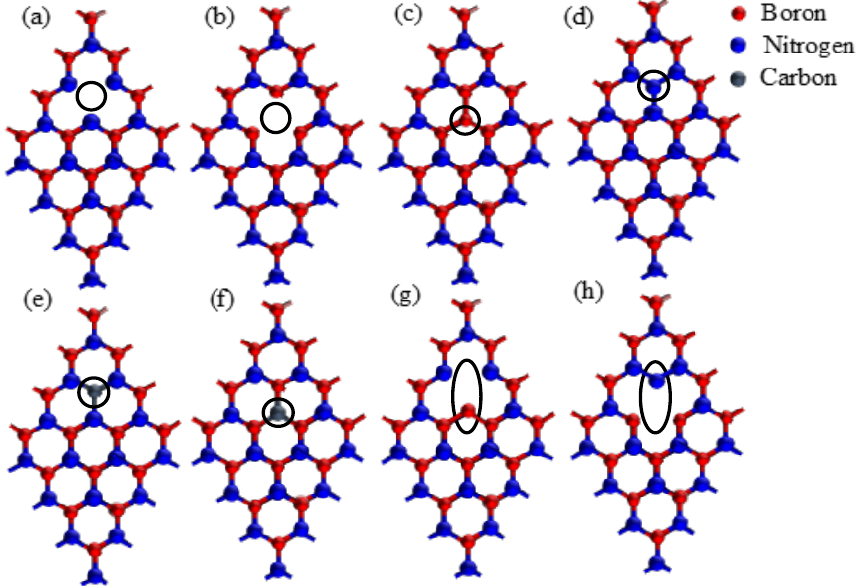
Figure 1. Schematic drawing of hBN monolayer supercells with various defects of ( a ) boron vacancy (V B ), ( b ) nitrogen vacancy (V N ), ( c ) substitution of boron for nitrogen (B N ), ( d ) substitution of nitrogen for boron (N B ), ( e ) substitution of carbon for boron (C B ), ( f ) substitution of carbon for nitrogen (C N ), ( g ) substitution of boron nitrogen and boron vacancy (B N -V B ), and ( h ) substitution of nitrogen for boron with nitrogen vacancy (N B -V N ).